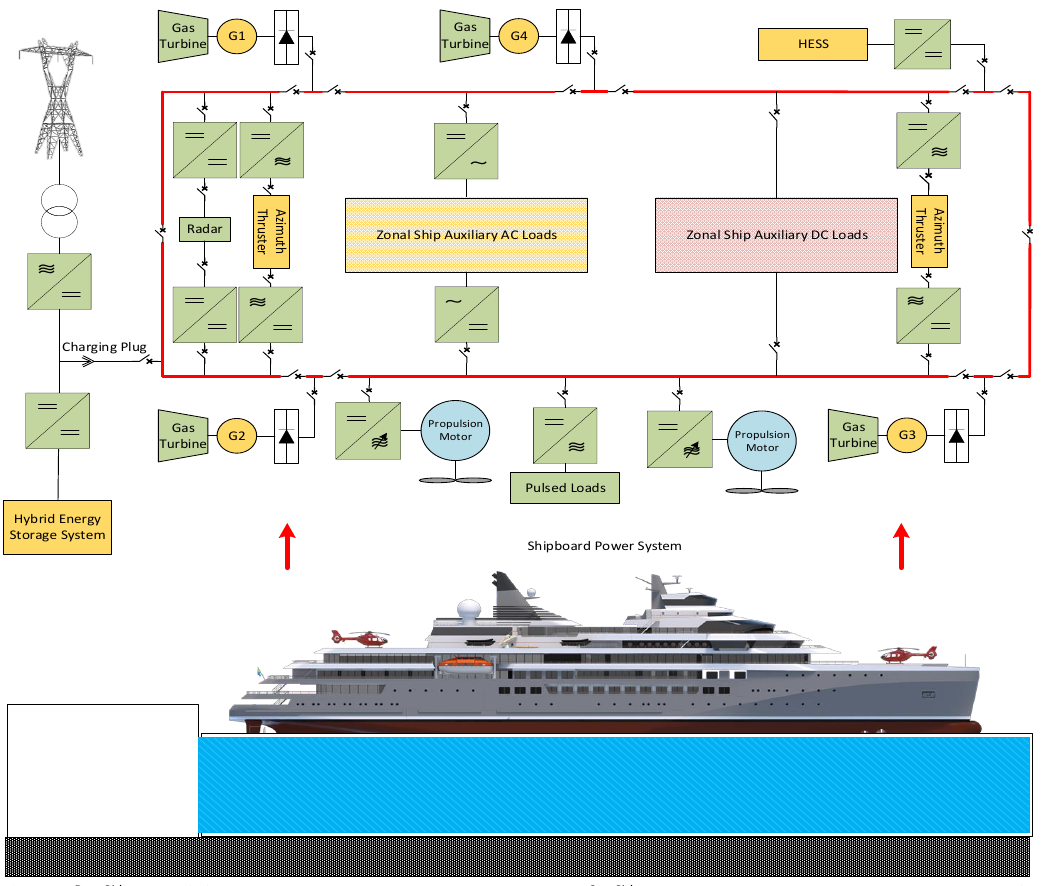
Figure 2. Typical single line diagram of the electrical power system for future